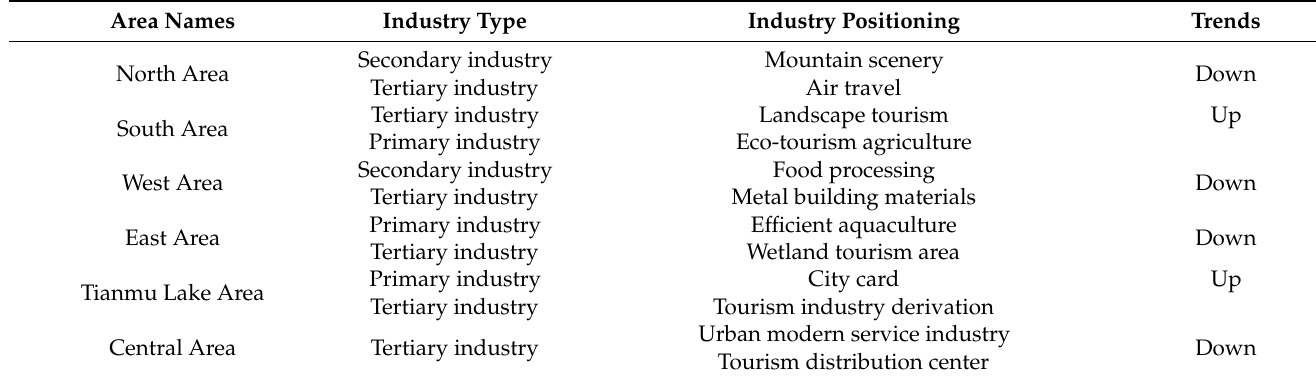
Table 11. Current industrial development status of each